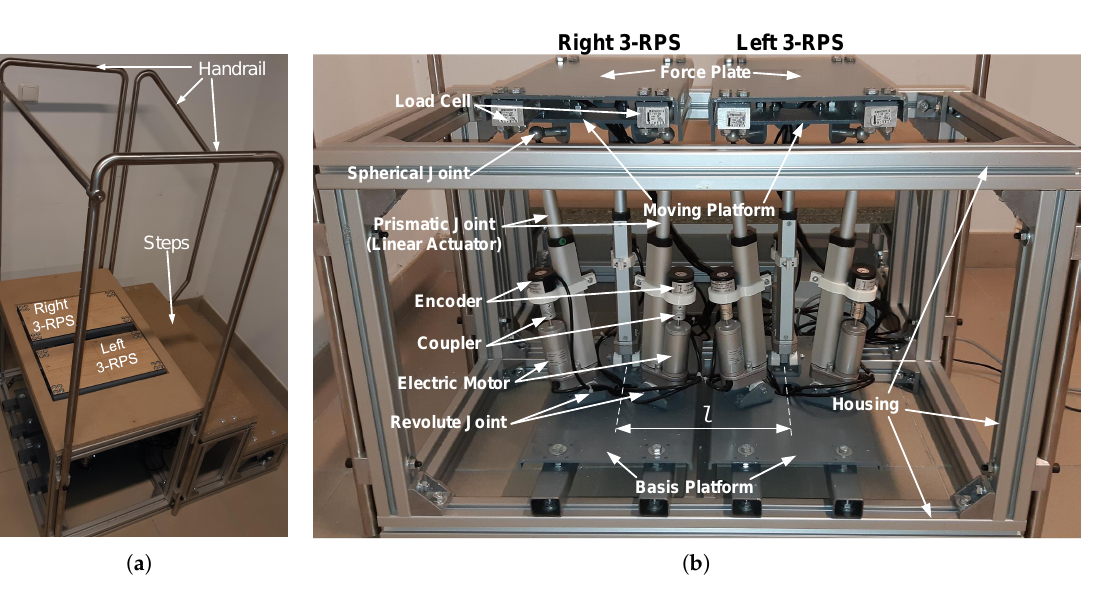
Figure 14. Parts of the mechanical set with two 3-RPS parallel manipulators with moving force plates: ( a ) handrail and steps of the mechanical set; and ( b ) left and right 3-RPS parallel manipulators with moving force